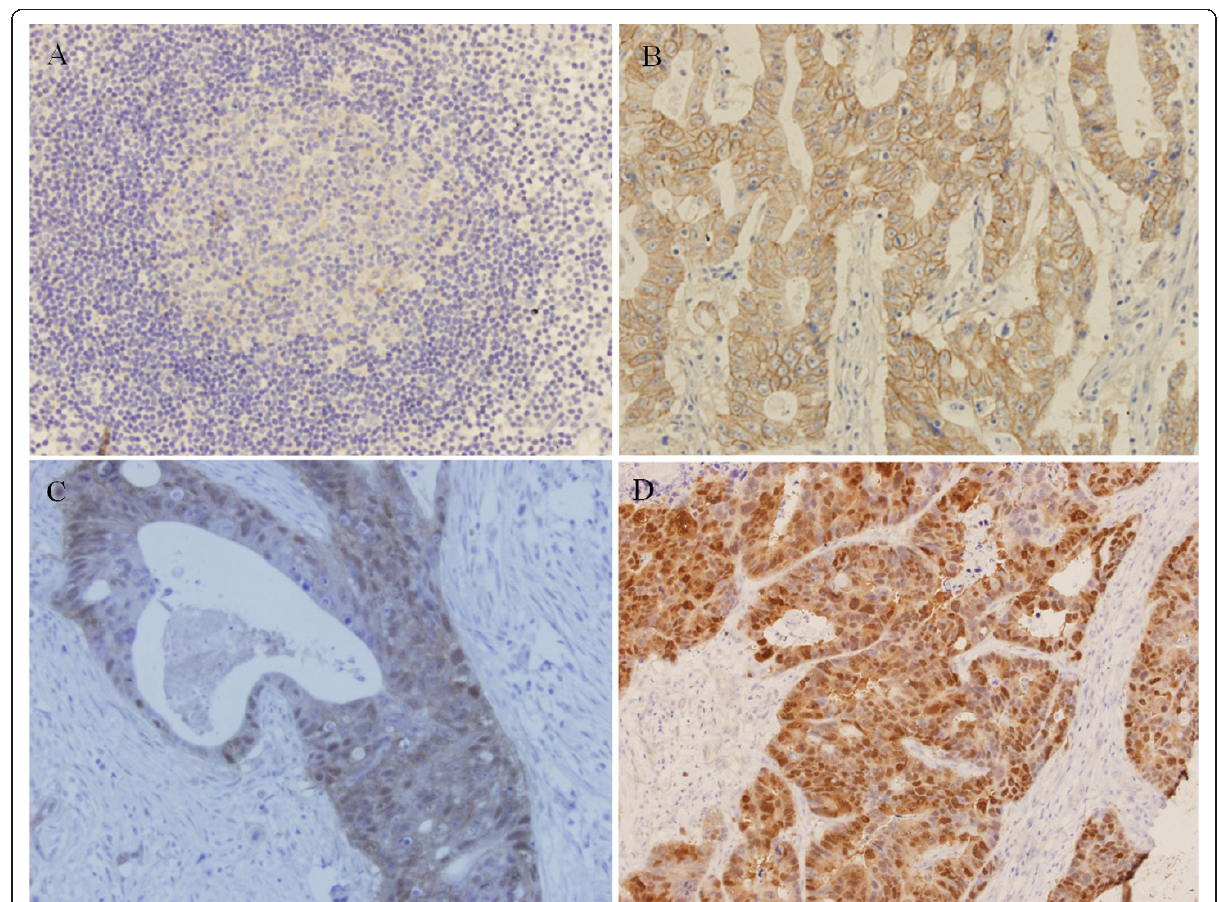
Figure 1 Beta-catenin expression in metastatic SLN(s) and liver metastatic lesions (×400) . (A) Normal SLN (B) beta-catenin presents mostly in a membrane-associated staining pattern in metastatic SLN(s) in patients without liver metastasis (C) Nuclear beta-catenin is overexpressed in